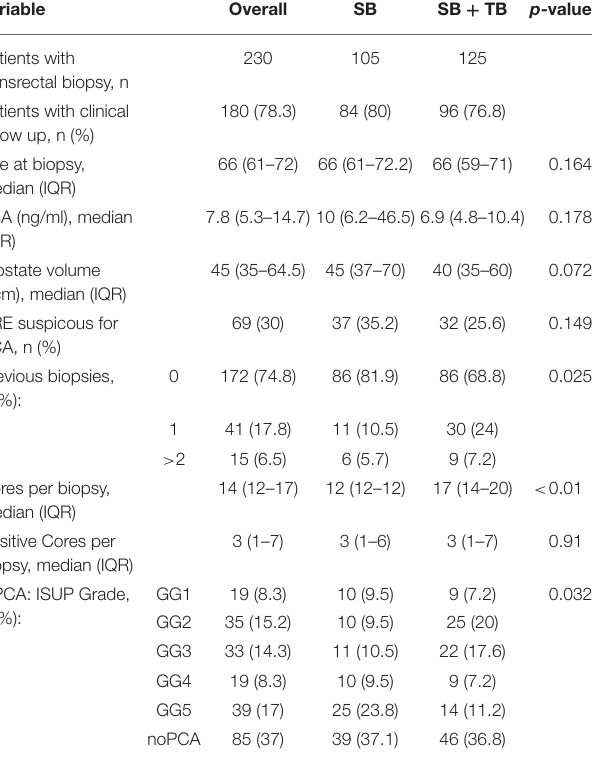
TABLE 1 | Baseline characteristics for patients with transrectal prostate biopsy at University Hospital Frankfurt between 01/2018 and 05/2019 stratified for SB and SB + TB.